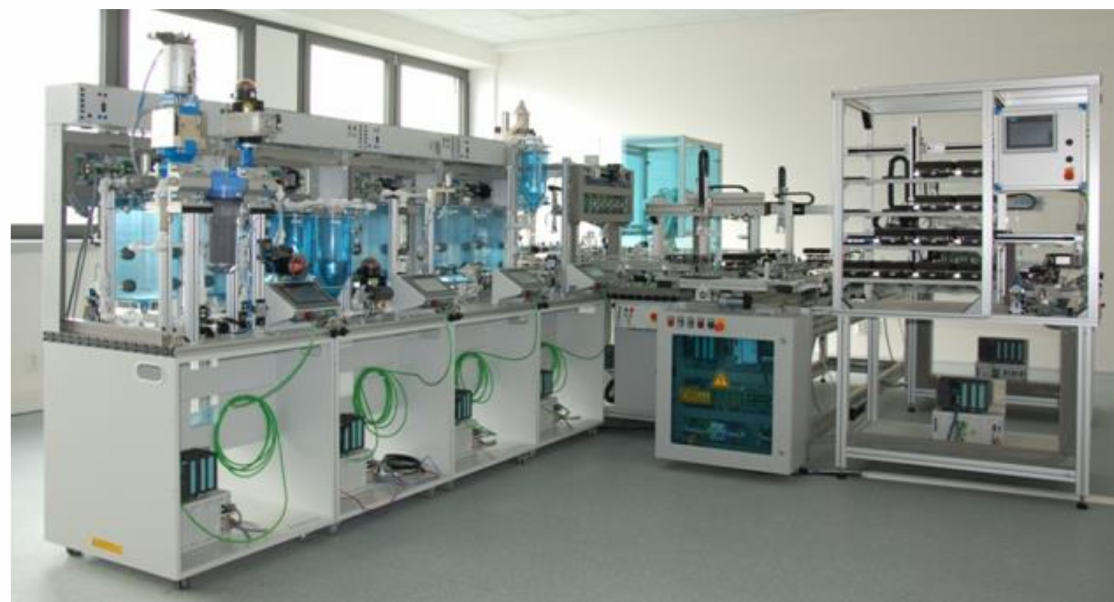
Figure 1. Real production